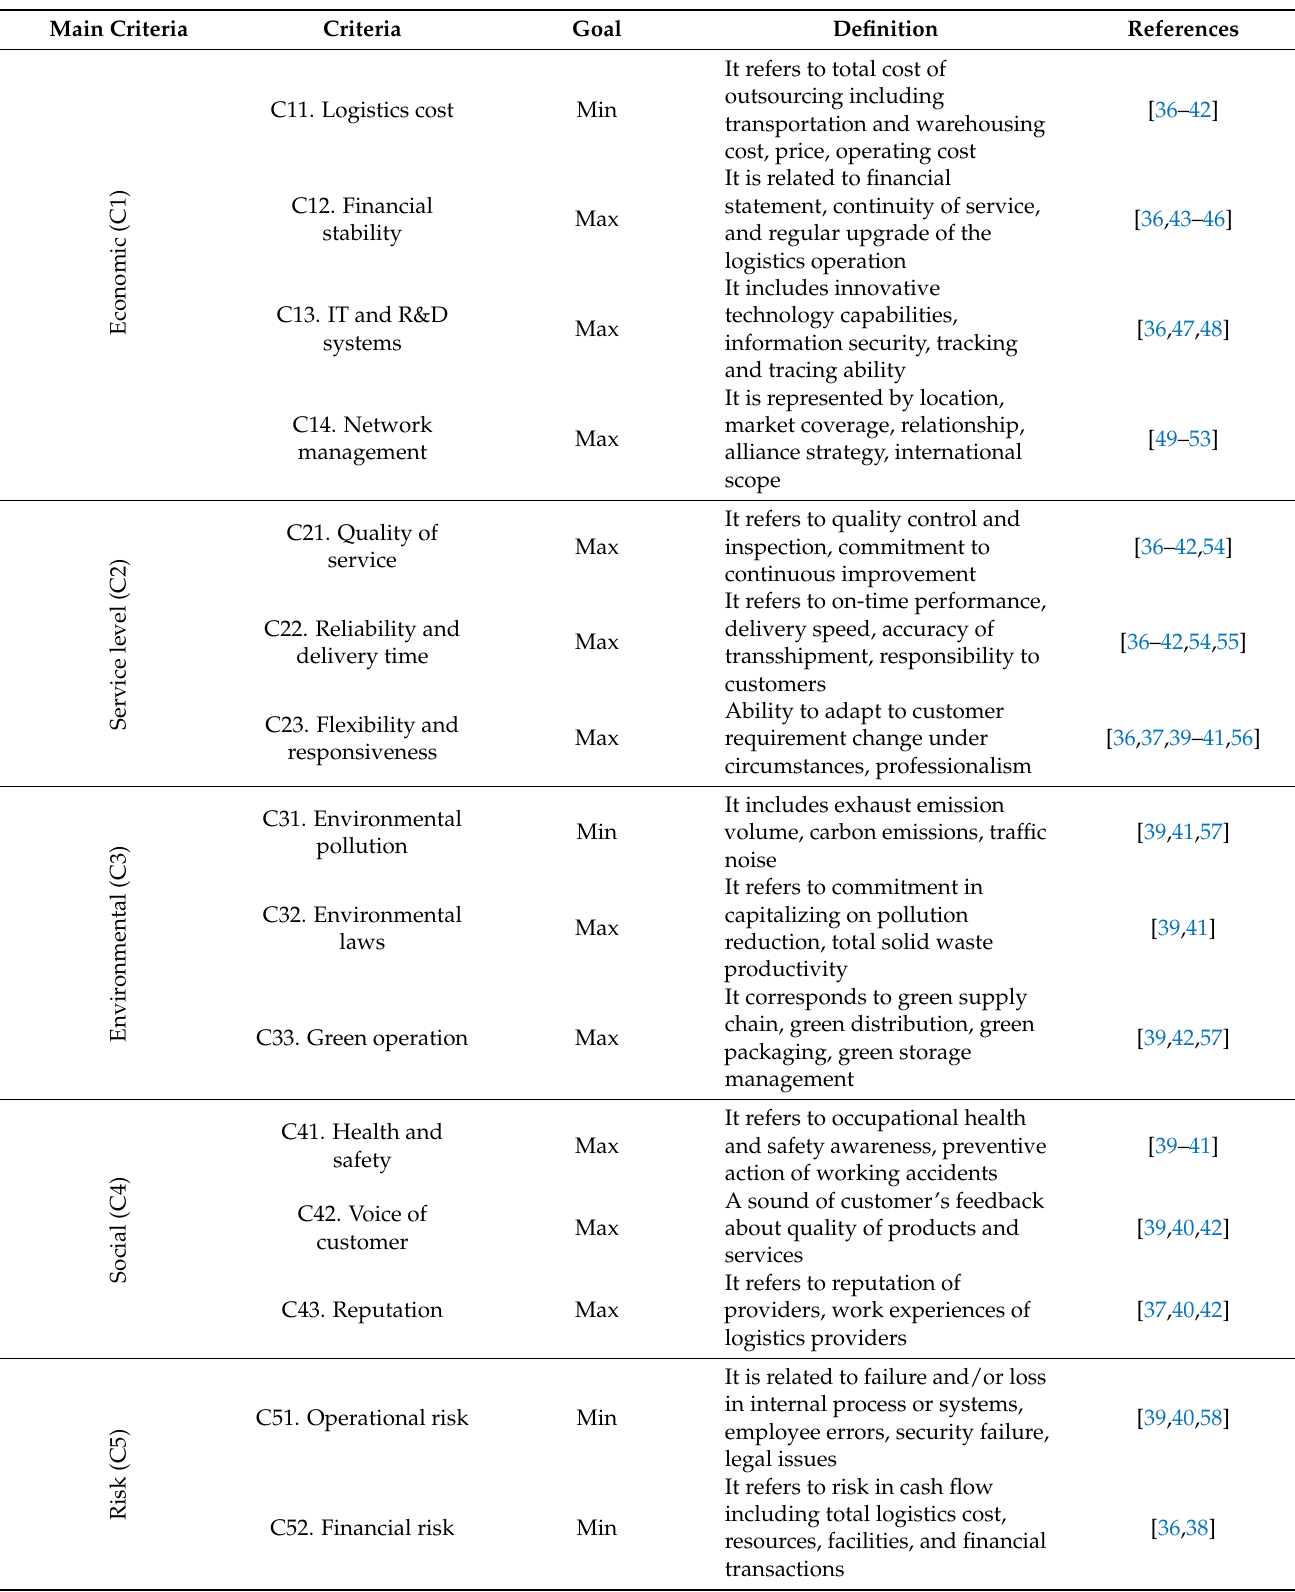
Table 2. The list of criteria for 3PL selection and their